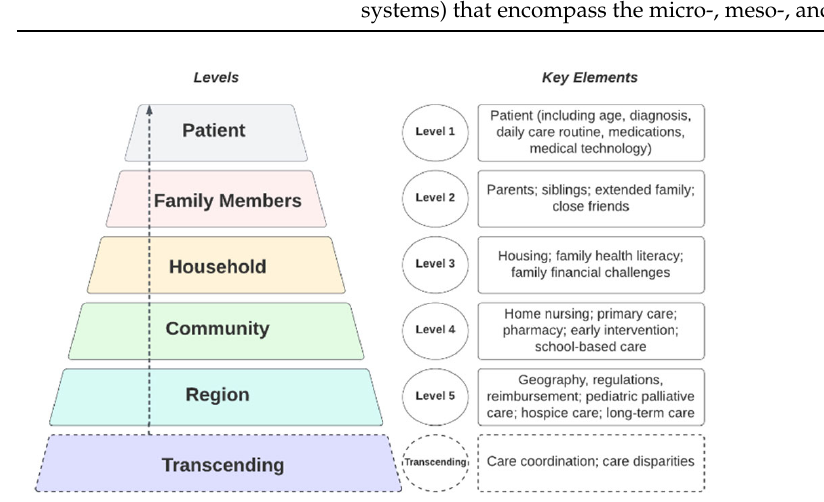
Figure 1. Multilevel ecological framework of home-based care for children with serious illness and their families. Created in Lucidchart (www.lucidchart.com accessed on 21 July 2022).